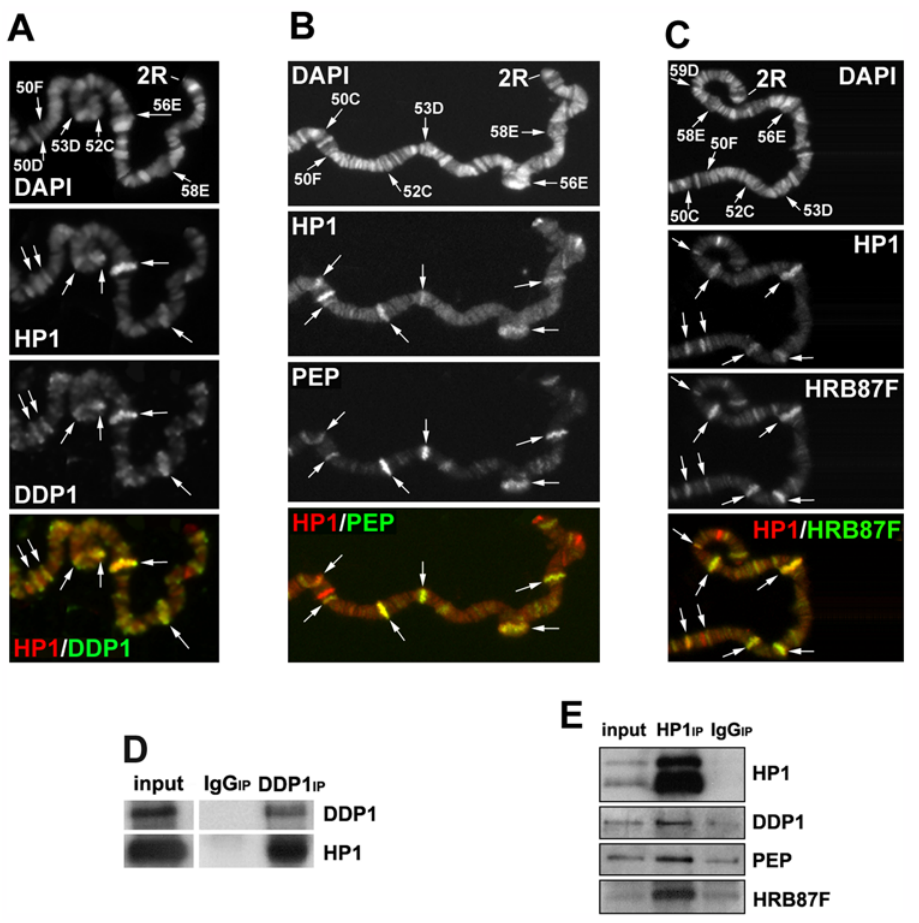
Figure 4. HP1a associates with and colocalizes on polytene chromosomes with DDP1, HRB87F, and PEP hnRNP proteins. (A–C) A part of the right arm of a wild type polytene second chromosome simulteneously immunostained with the anti-HP1a antibody and an antibody against: (A) DDP1, (B) PEP, and (C) HRB87F. There is an extensive colocalization of HP1a with each of the other proteins (arrows). We could not perform simultaneous immunostaining among the DDP1, PEP and HRB87F because the available specific antibodies were made in mouse. However, the colocalization of each protein with HP1a in same regions indicated that all the proteins colocalize in such regions. (For simultaneous immunostainings on whole polytene chromosomes, see Figure S3). (D) Coimmunoprecipitation of HP1a with DDP1 by an anti-DDP1 antibody. (E) Coimmunoprecipitation of HP1a with DDP1, PEP, and HRB87F proteins by the C1A9 anti-HP1a antibody.